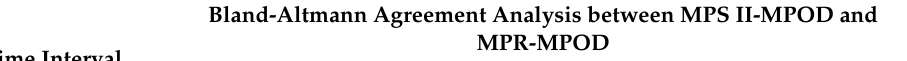
Table 5. Agreement between MPS II-MPOD (macular pigment optical density) and MPR-MPOD measurements with and without pupillary